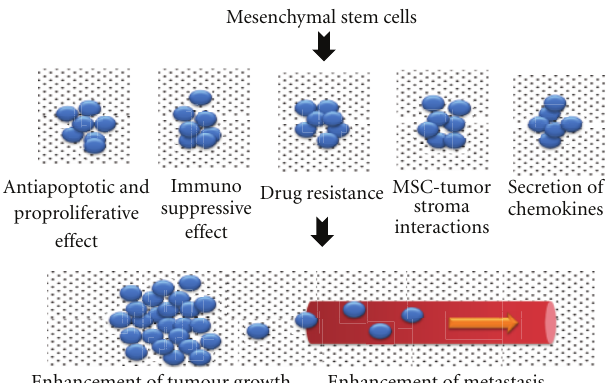
Figure 1: Indirect involvement of mesenchymal stem cells in cancer through tumour modulatory and other e ff ects. exert antiapoptotic e ff ect in U266 and H929 melanoma cells mediated by upregulation of survivin